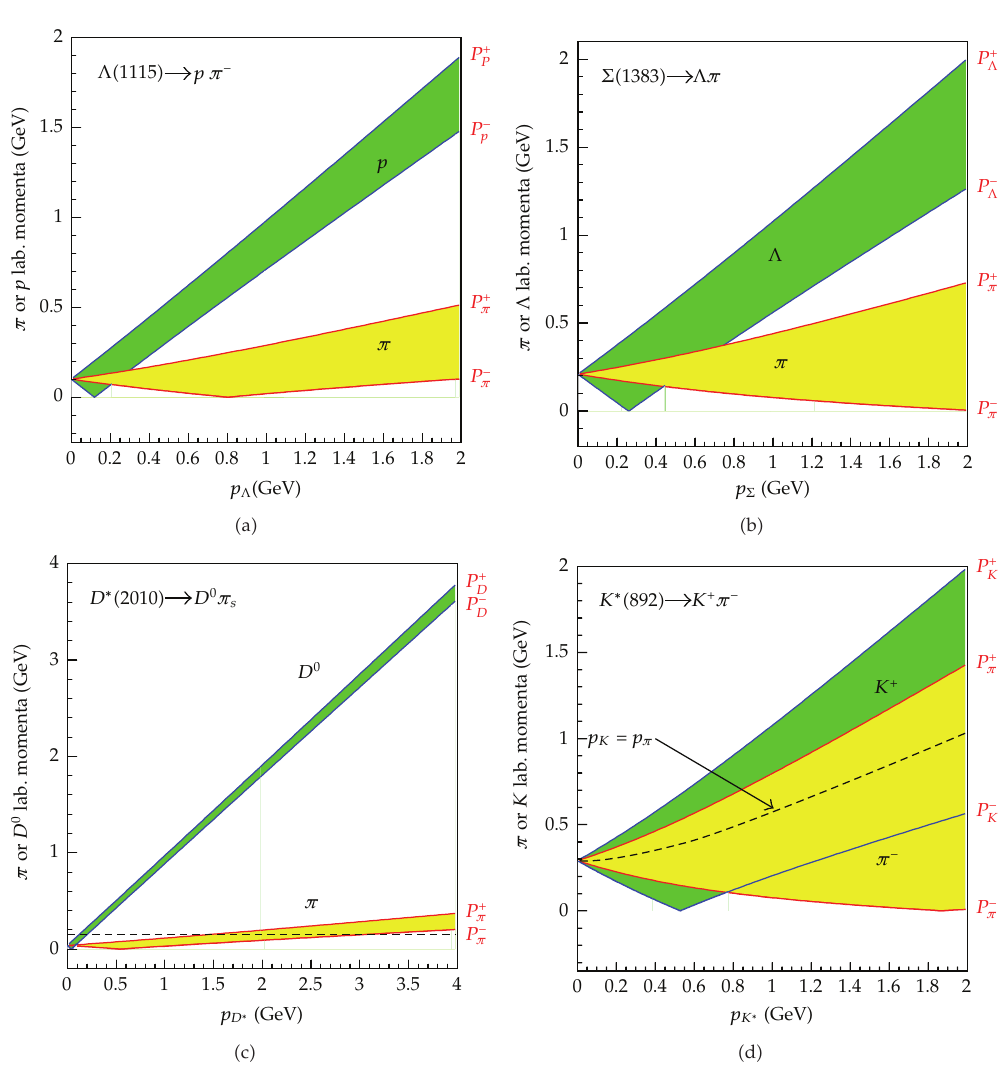
Figure 1: Phase space m -bands of the particles a and b in R → a (cid:9) b decays as a function of the resonance momentum P R . The dashed line on (cid:3) c (cid:4) corresponds to the momentum cut p π (cid:10) 0 . 15 GeV (cid:3) see Section 3 (cid:4) . The dashed line on (cid:3) d (cid:4) corresponds to (cid:3) 2.12 (cid:4)